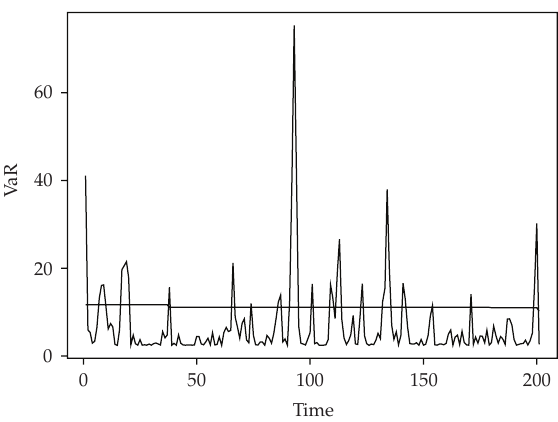
Figure 2: True and Historical Simulation-Based VaRs.